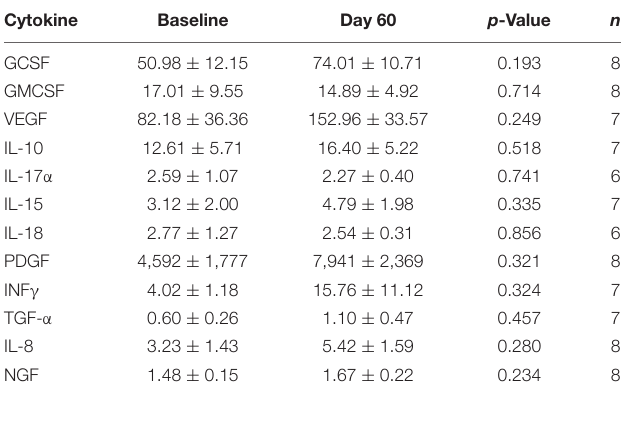
correlation table. Data from a subject on a given measure was sometimes omitted due to undetectable baseline readings, inconsistent duplicate values, or as a clear outlier (Grubb’s single outlier test).